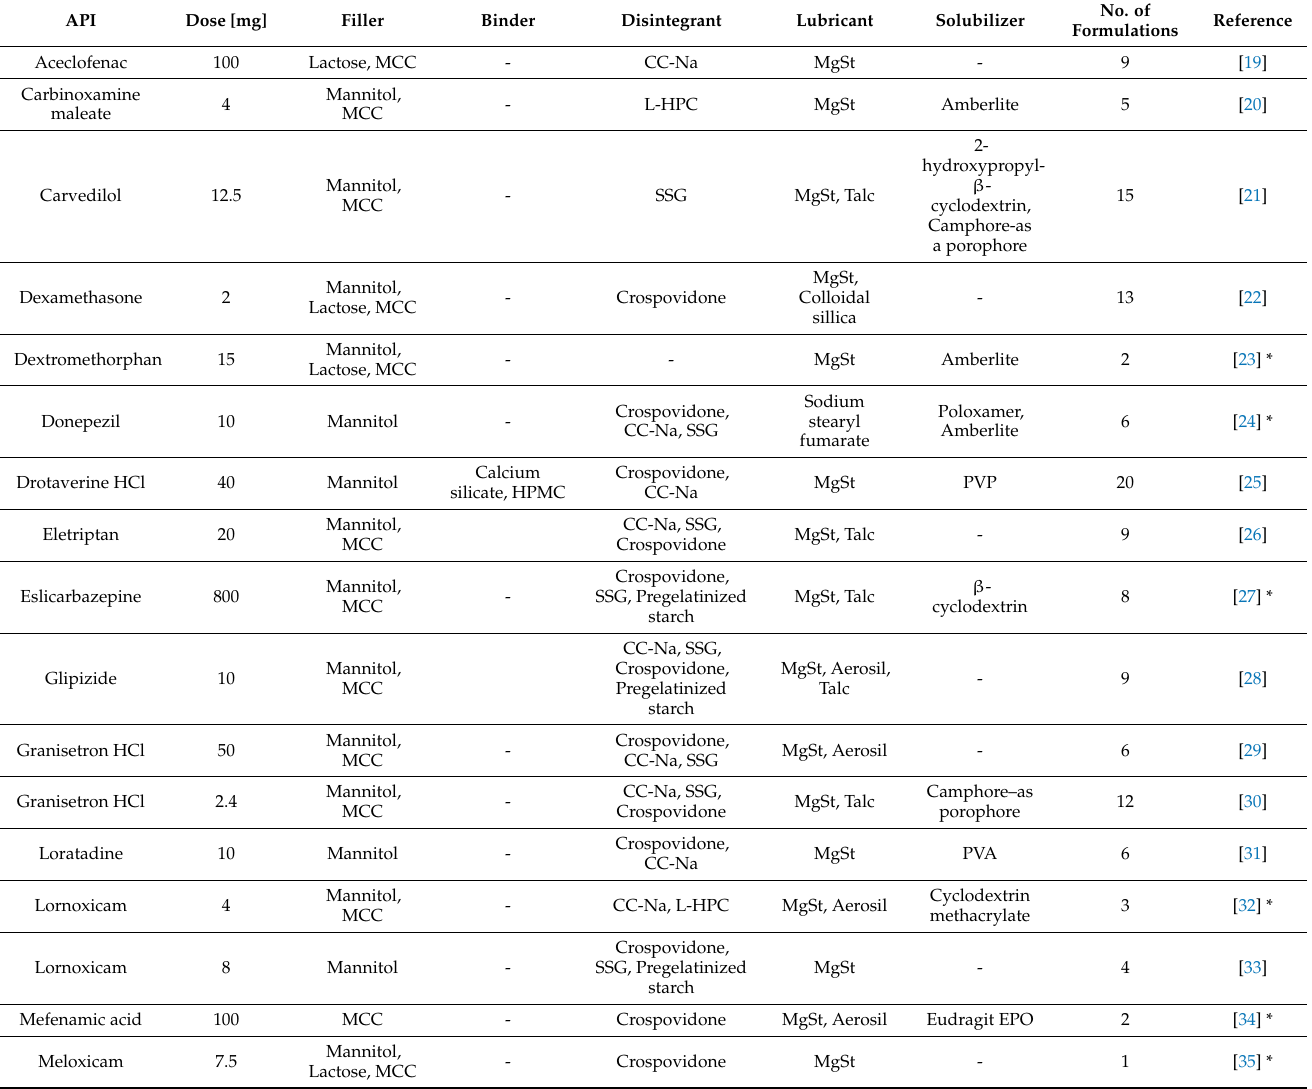
Table 1. Source of data–publications